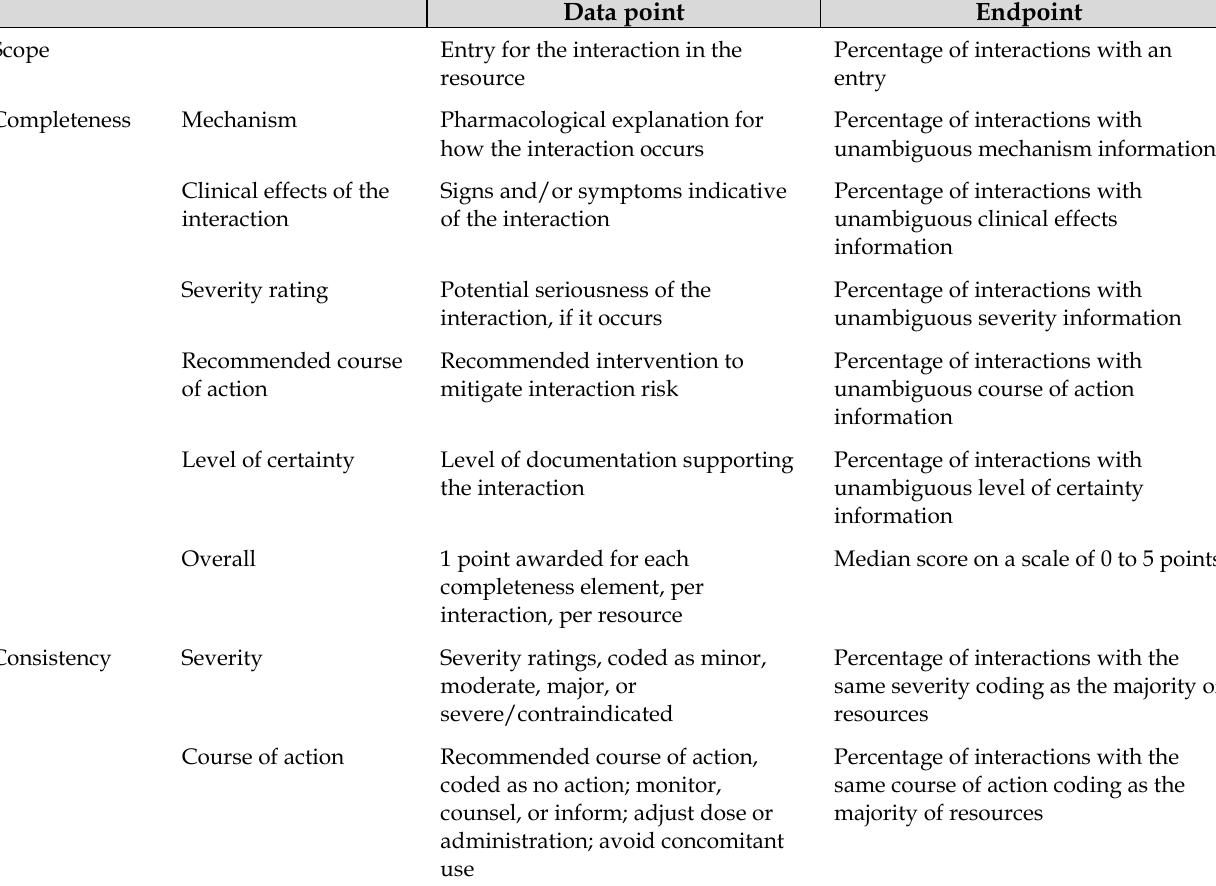
Table 1 Collected data points and